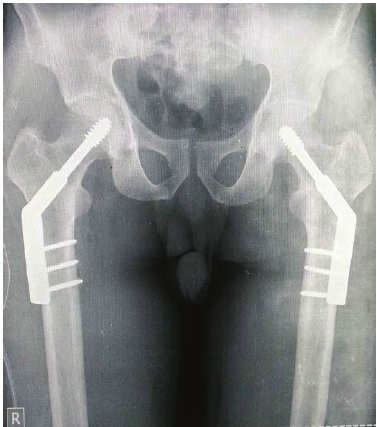
Figure 5: Immediate postoperative X-ray of bilateral hip joint with pelvis showing 3 holed dynamic hip screw implant in